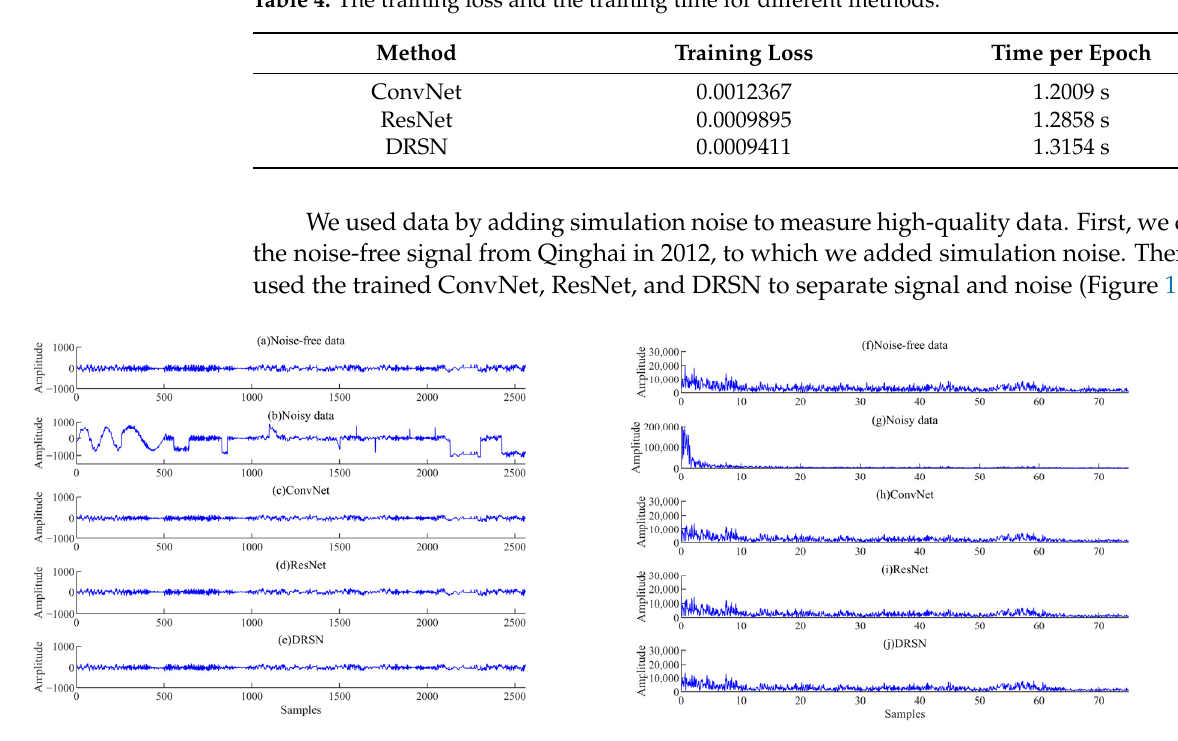
Figure 11. Denoising results for the data with noise. Time domain waveform of ( a ) Noise-free data, ( b ) Noisy data, ( c ) the results of ConvNet, ( d ) the results of ResNet, and ( e ) the results of DRSN. Spectrum of ( f ) Noise-free data, ( g ) Noisy data, ( h ) the results of ConvNet, ( i ) the results of ResNet, ( j ) the results of DRSN.